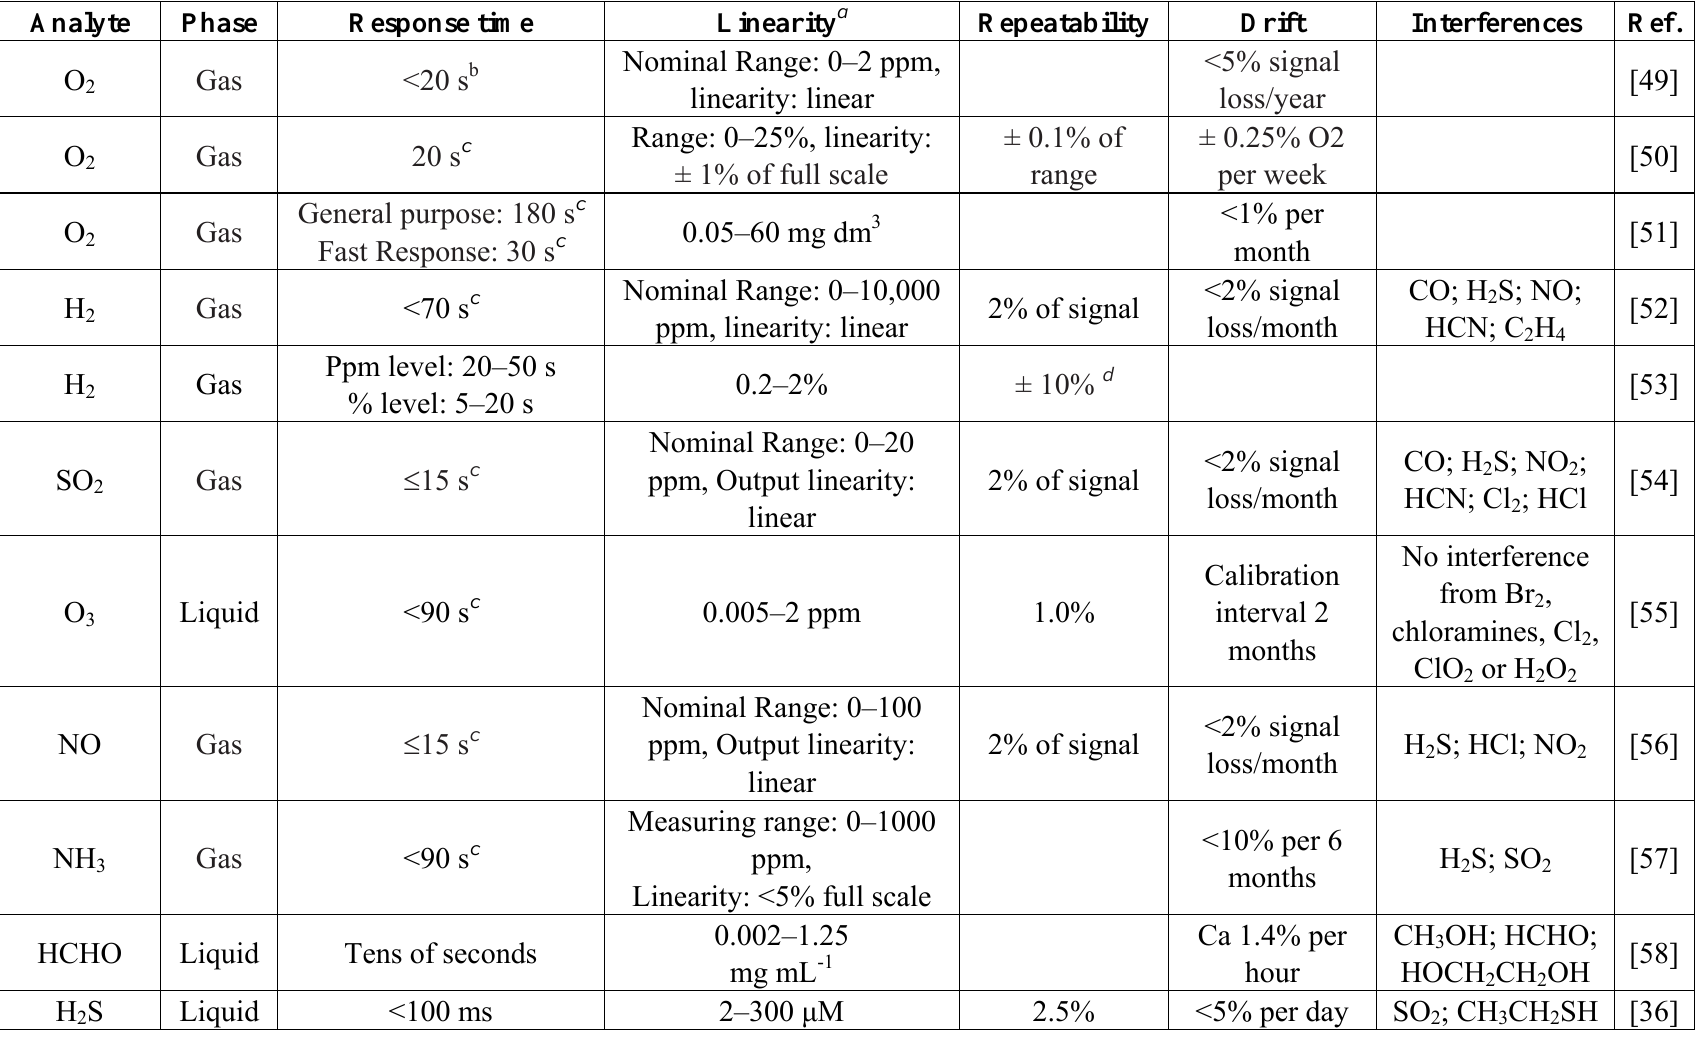
Table 1. Uncertainty sources of amperometric sensors discussed in the